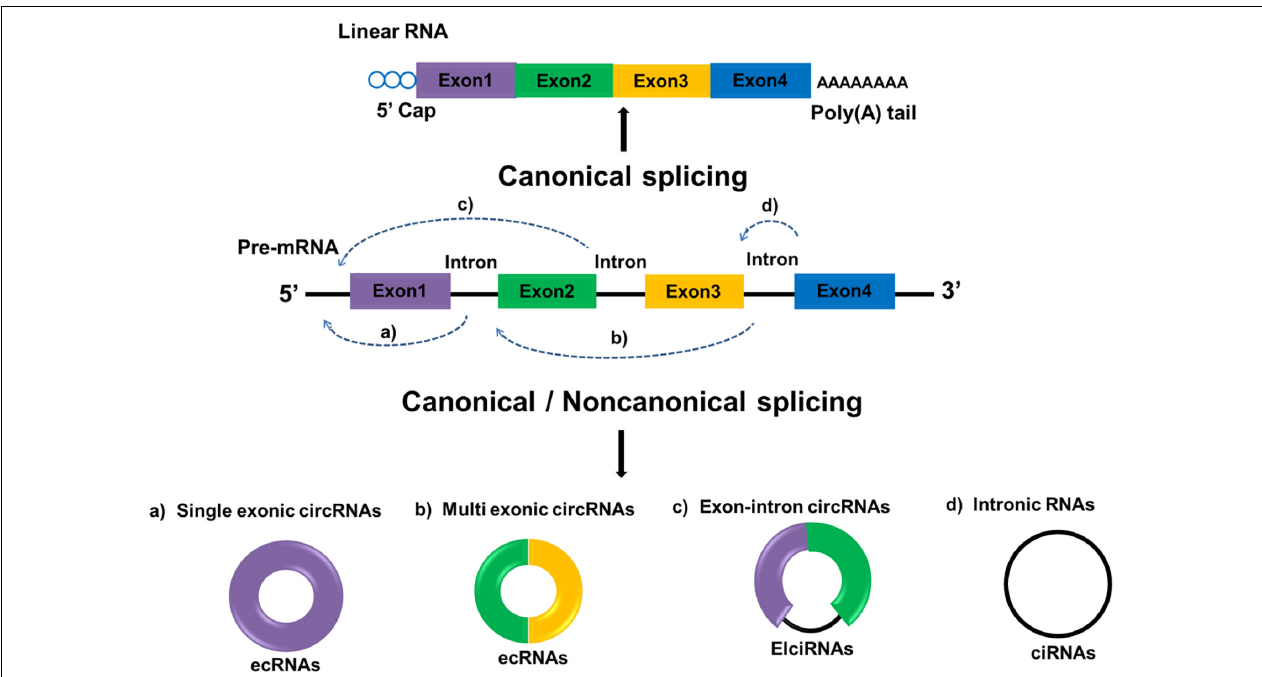
FIGURE 1 | Biogenesis of circRNA. Linear mRNAs are produced by canonical splicing while circRNAs can be produced through both canonical and non-canonical splicing. Exon-derived circRNA (ecRNA) generates from single exons (a) or multiple exons (b) . Exon–intron circRNA (EIciRNA) consists of two exons between which an intron is inserted (c) . Circular intronic RNA (ciRNA) generates from only introns (d) . Rectangles in different colors represent exons and black lines represent introns.